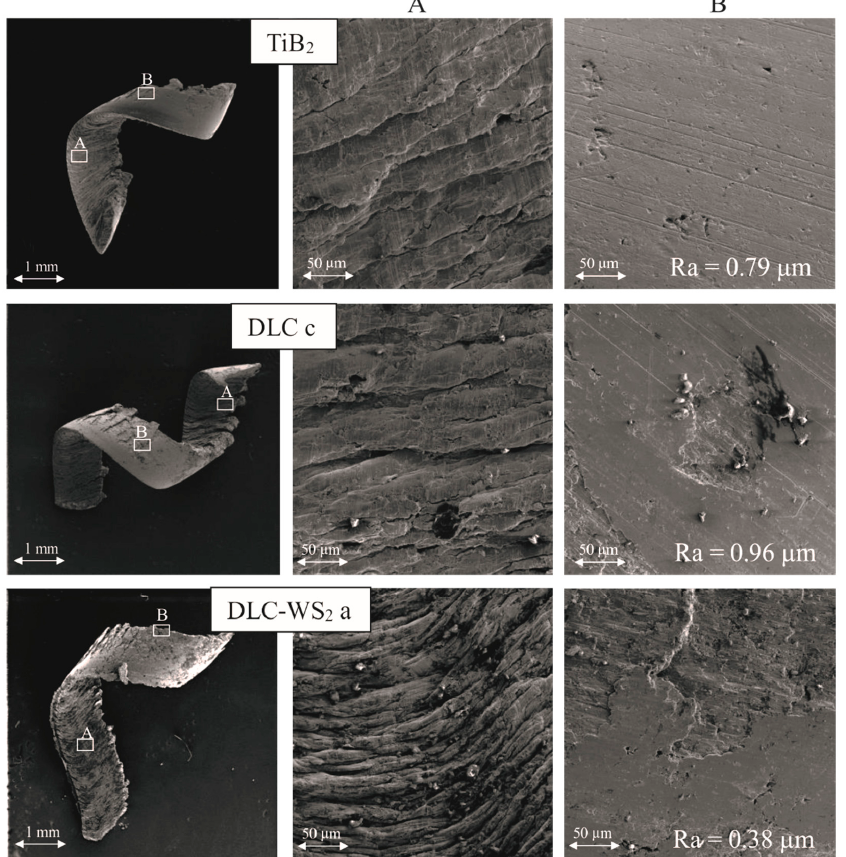
Figure 12. SEM images of the chip shapes and underside surfaces produced by coated